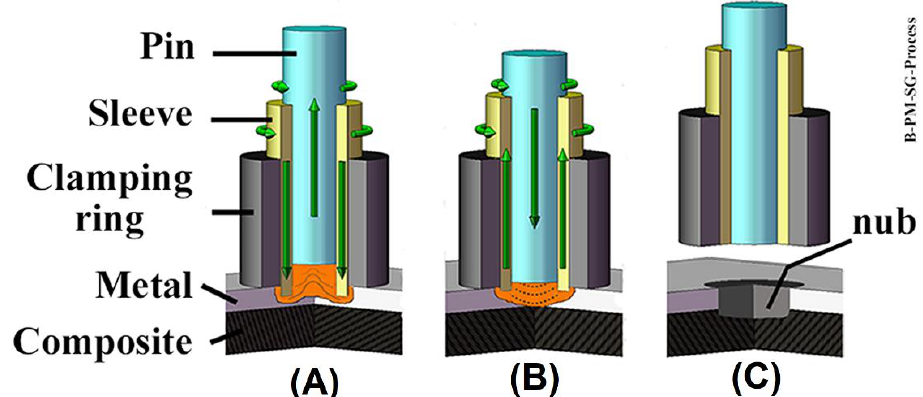
Figure 1. Description of the FSpJ process in three steps: ( A ) sleeve plunging, softening and deformation of the metal part; ( B ) spot refilling; ( C ) retraction of the tool and joint consolidation. (Adapted from Reference [14]).